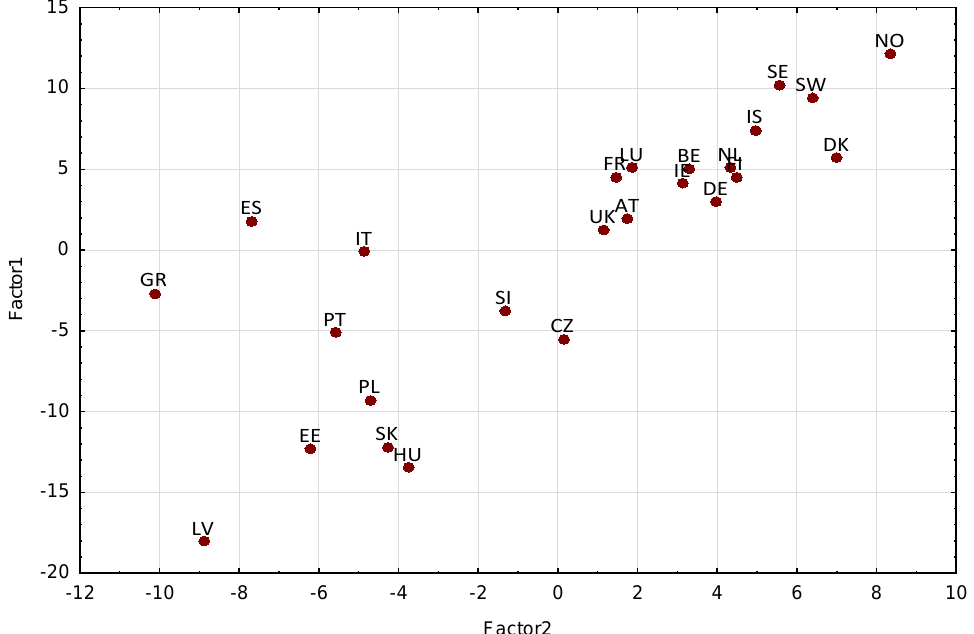
Figure 3. Location of countries in the coordinate system of the factors F1, F2. Source: self-processed in